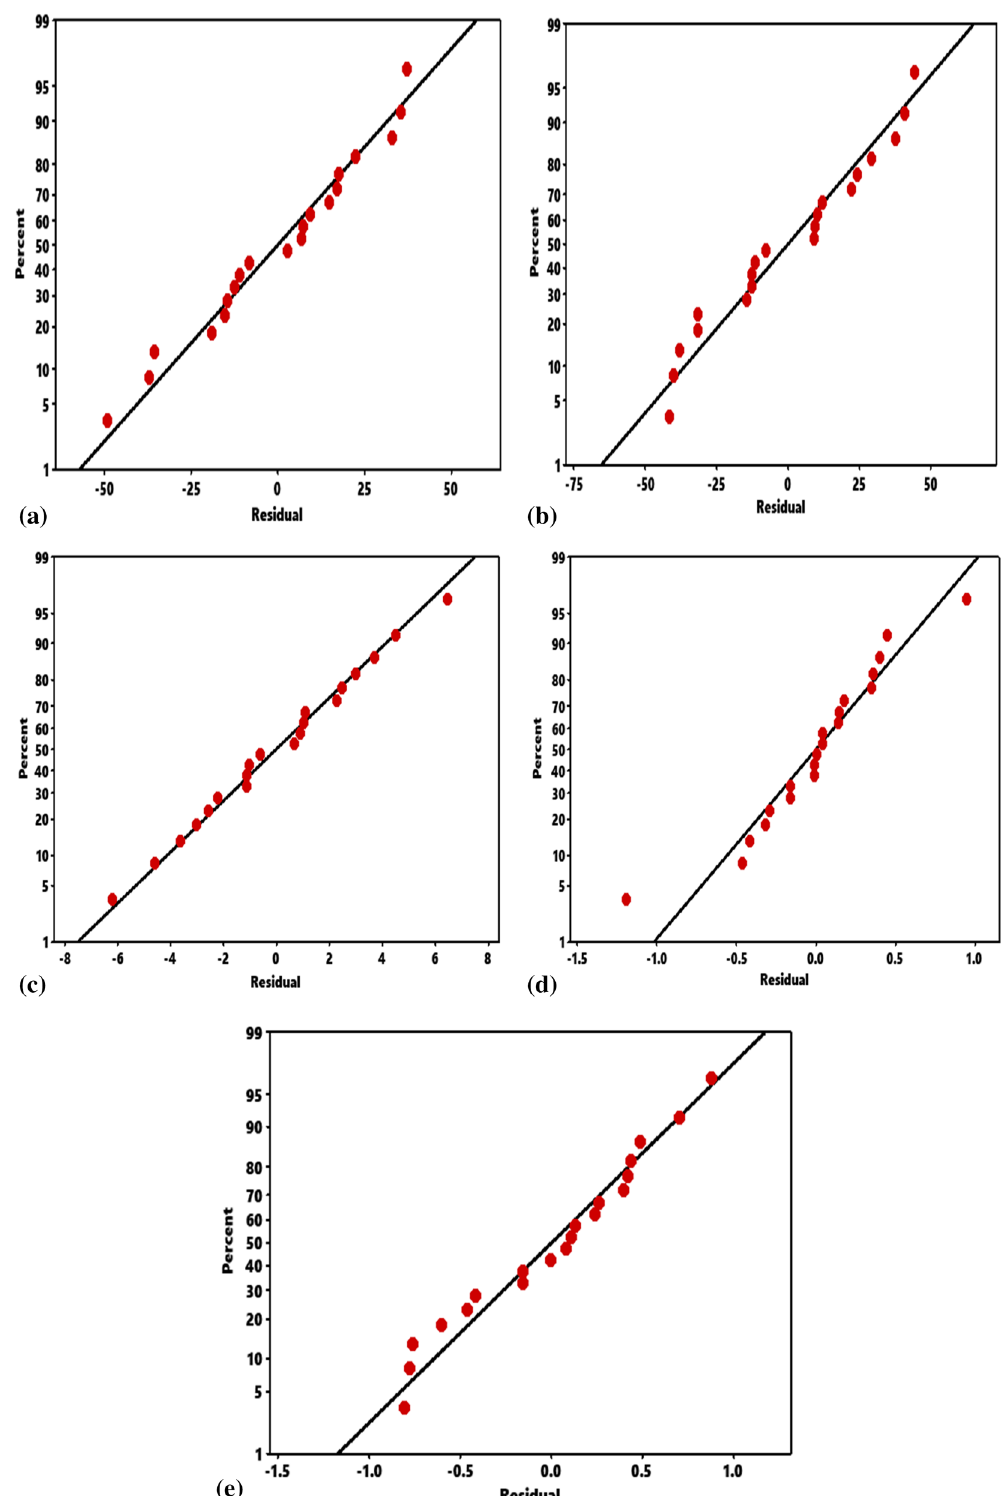
Figure 1. Normal probability plot for responses. ( a ) Ultimate tensile strength, ( b ) hardness, ( c ) impact strength, ( d ) elastic modulus, ( e ) compressive